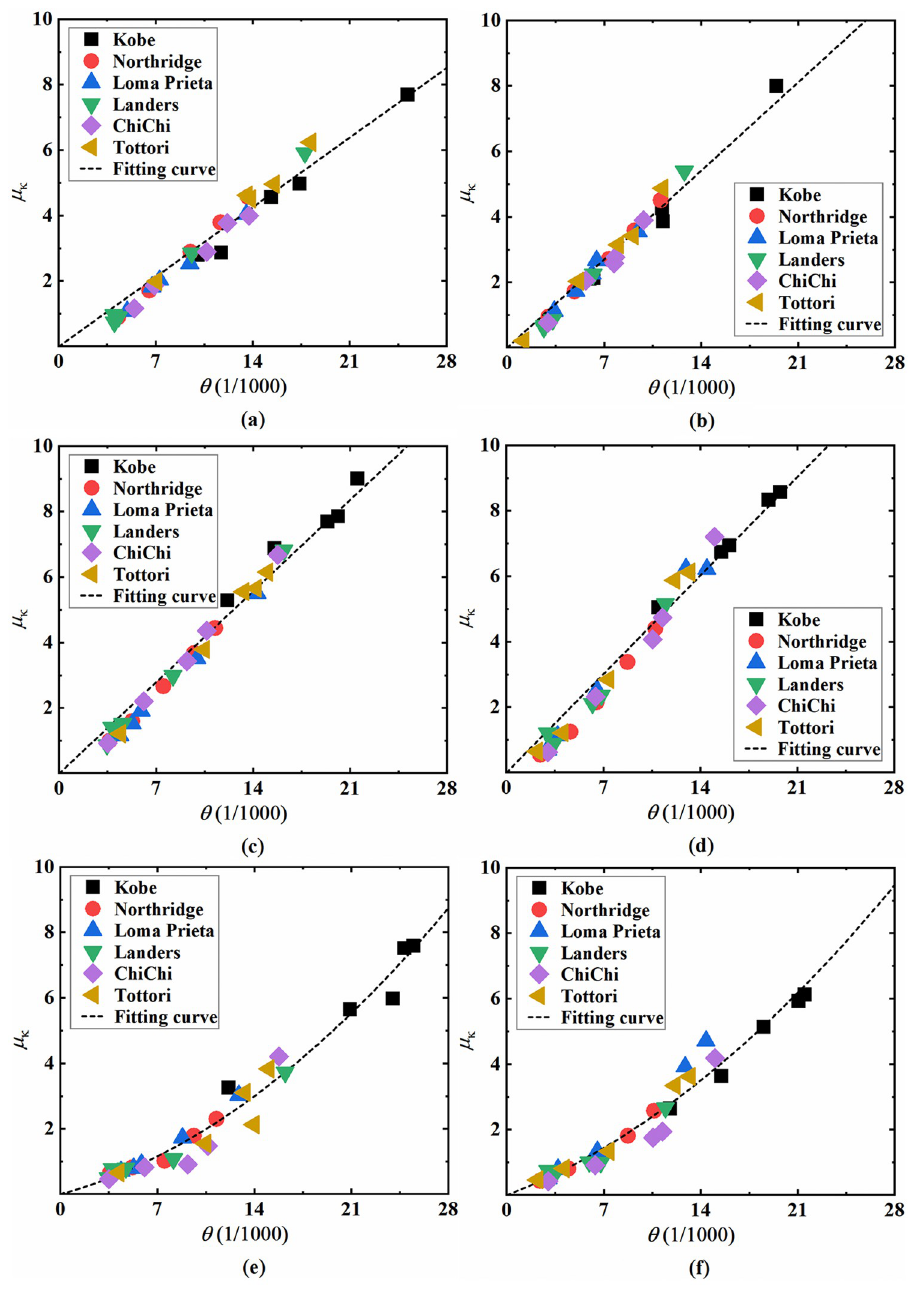
Fig 18. Bending deformation of component sections at site 3. (a) Top section of the double-storey station’s top column, (b) Top section of the three-storey station’s top column, (c) Bottom section of the double-storey station’s bottom column, (d) Bottom section of the three-storey station’s bottom column, (e) Bottom section of the double- storey station’s sidewall, (f) Bottom section of the three-storey station’s